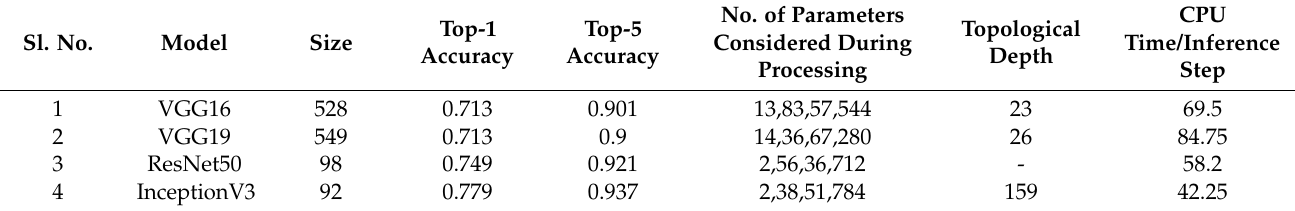
Table 1. Different convolution filter-based feature extractors and classification models.